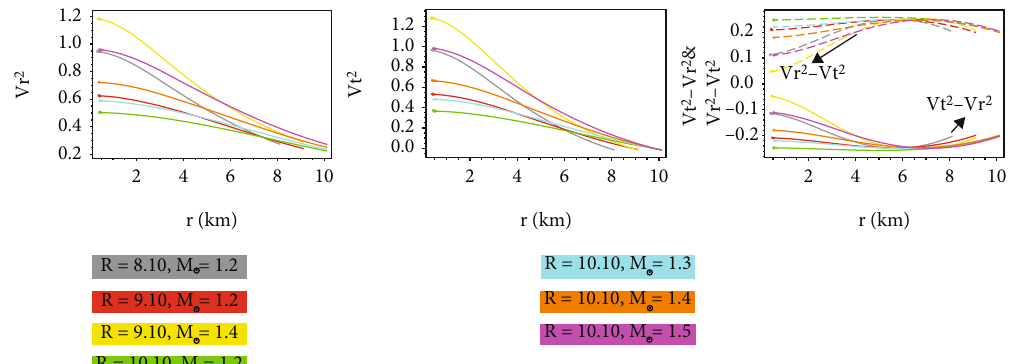
2 , v 2 , and v r t